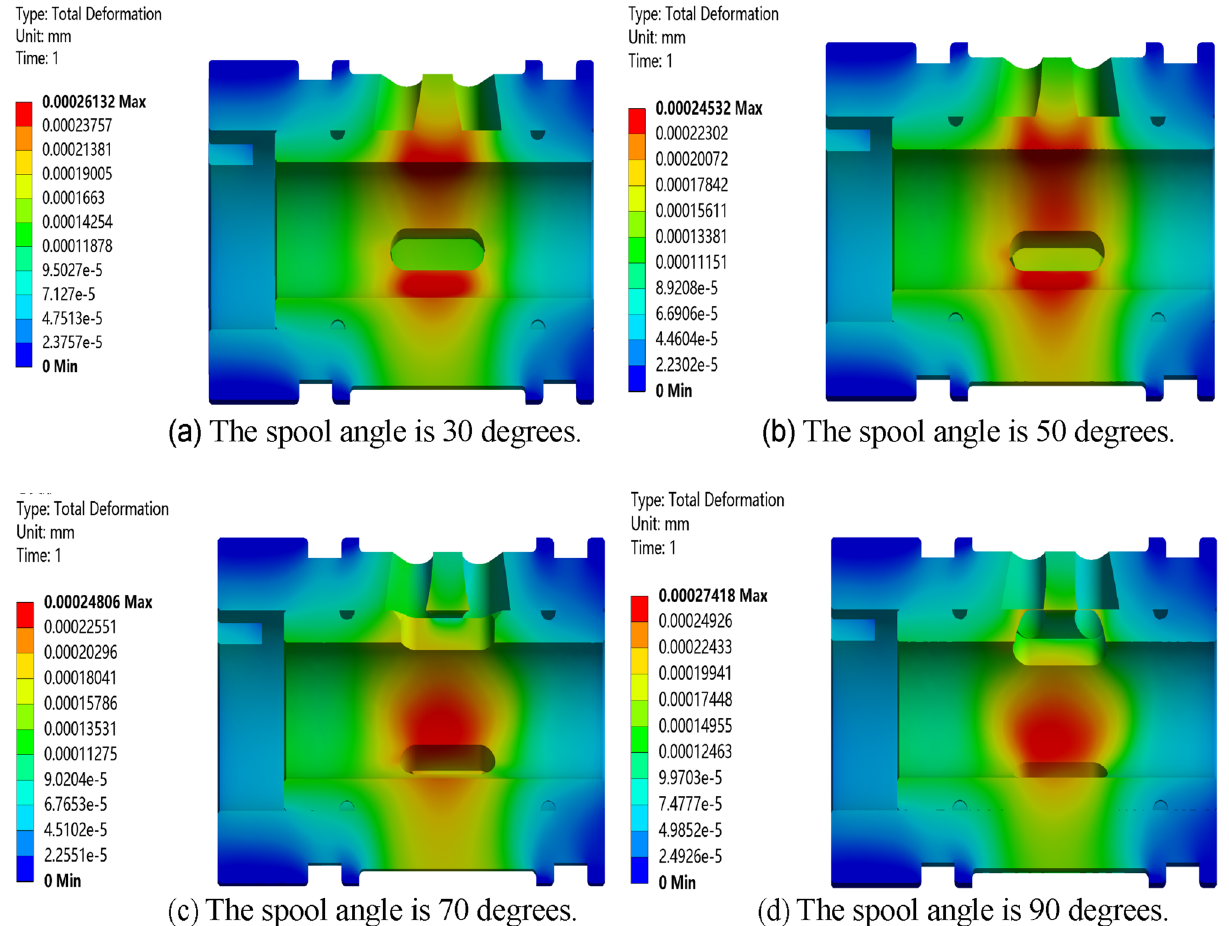
Figure 18. Deformation diagram of valve sleeve and valve core of triangular buffer